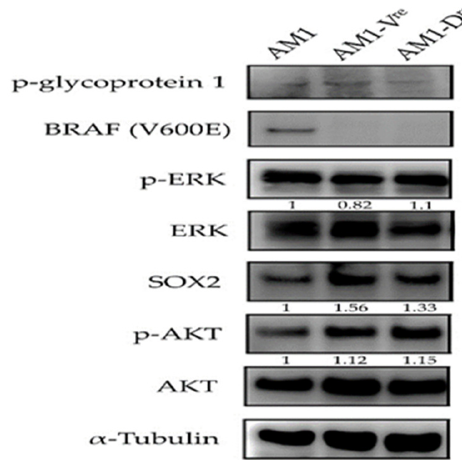
Figure 9. Western blot analysis of AM1 and its resistant clones to BRAF inhibitors. The AM1 cells express BRAF(V600E), while it was downregulated in the treated groups. BRAF inhibition induces upregulation of stemness marker SOX2 in AM1.